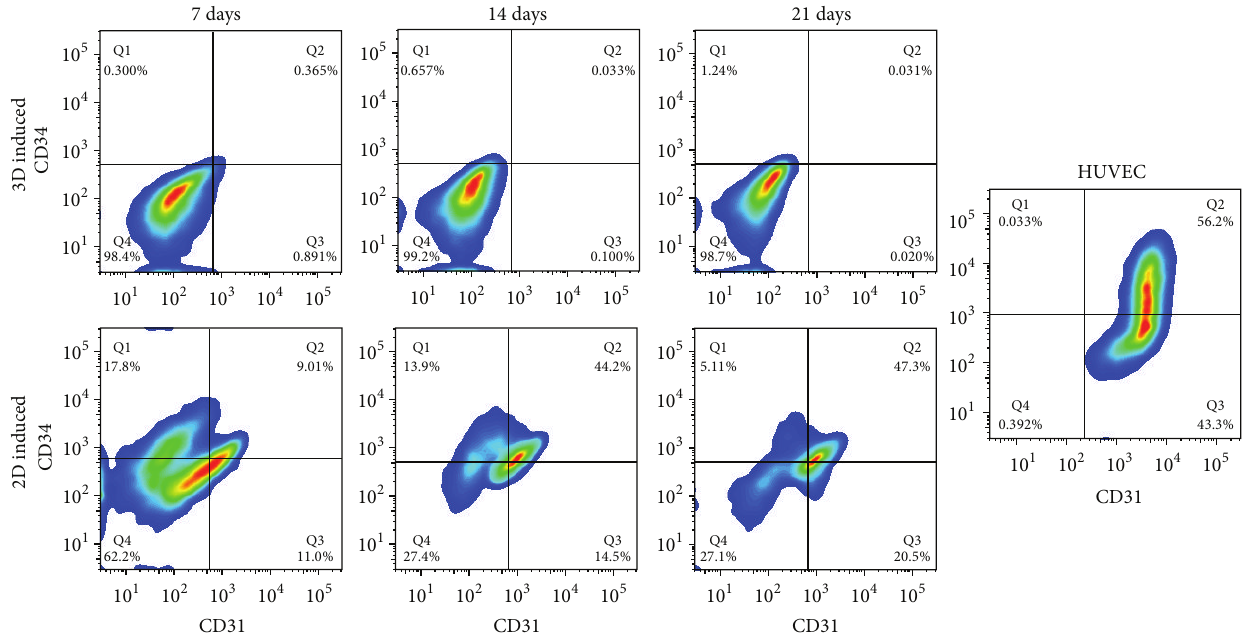
Figure 3: Expressions of CD34 and CD31 in 3D/2D induced